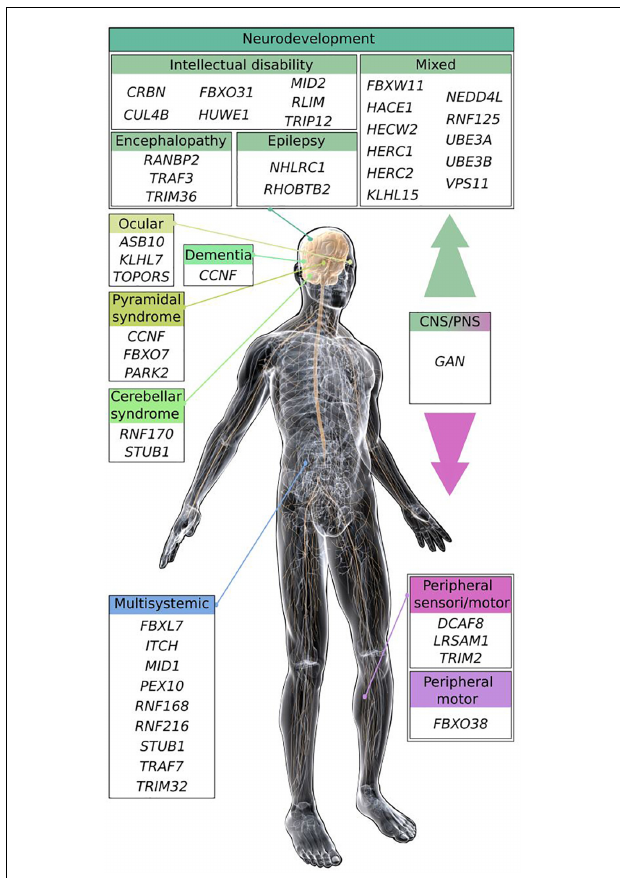
FIGURE 2 | Scheme of the main clinical features shared by E3 ligase encoding genes causing neurodevelopmental and neurodegenerative diseases. Most of the E3 ligase genes, when mutated cause neurodevelopmental diseases (intellectual disability, encephalopathy, and epilepsy), or regionalized neuropathies (cerebellar, ocular, and pyramidal syndrome) within the CNS. Some pathologies exhibit mixed symptoms that can be part of broader multisystemic disorders. E3 ligase genes inducing peripheral neuropathies are represented by Charcot-Marie-Tooth diseases (CMT), and distal hereditary motor neuropathy (HMN). The GAN E3 ligase gene causes a disease affecting broadly the nervous system, leading to a myriad of symptoms within the peripheral and the CNS. Illustration: © www.gograph.com/ Eraxion. Genes (protein if different), names of diseases and references (in alphabetical order): ASB10, Glaucoma (Pasutto et al., 2012); CCNF (cyclinF), Amyotrophic Lateral Sclerosis and